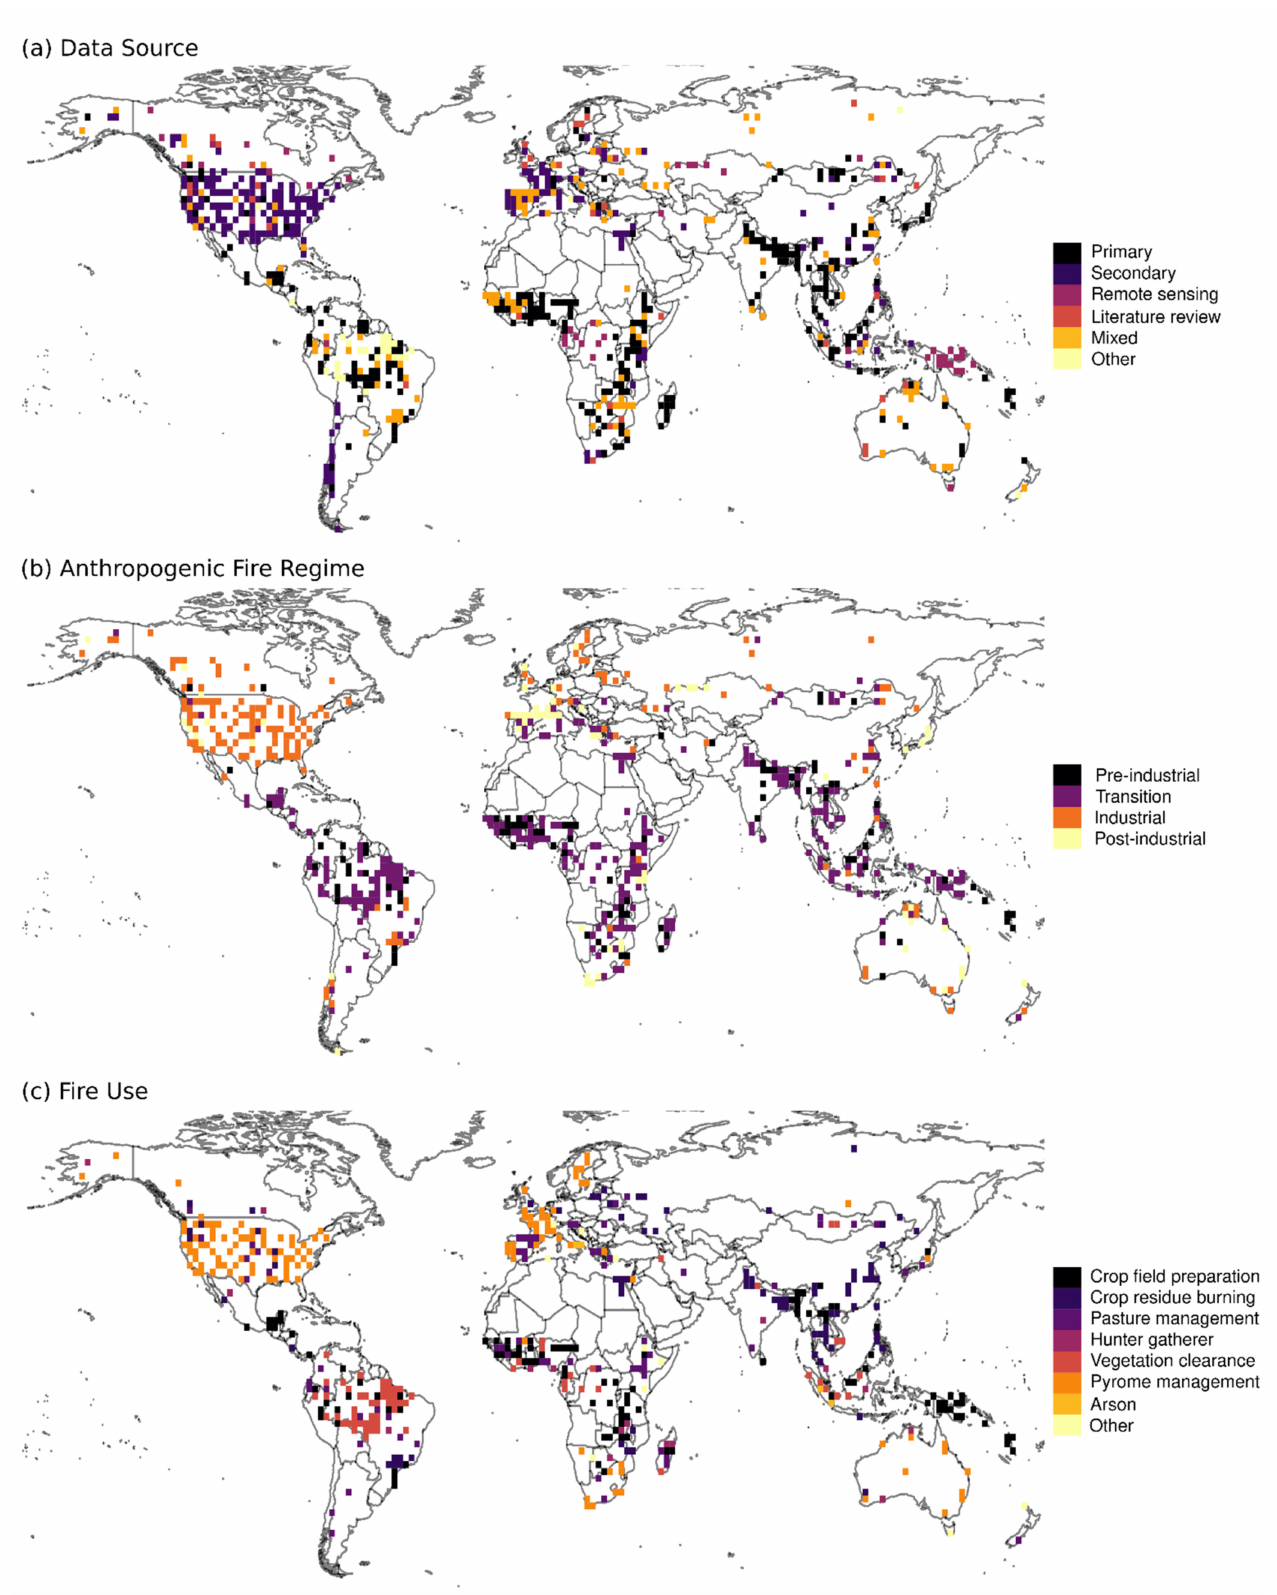
Figure 1. Spatial distribution of ( a ) case study data sources, ( b ) anthropogenic fire regimes and ( c ) fire use. Map grid has a resolution of 2 decimal degrees with the most prevalent source/regime shown for each grid